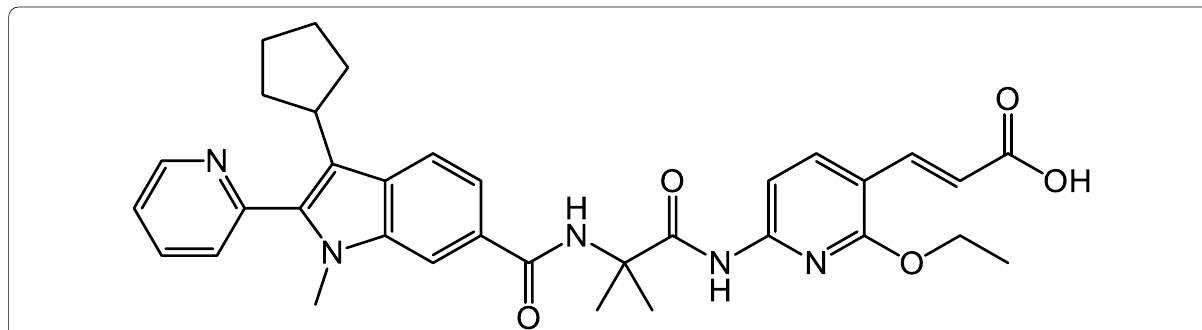
Fig. 4 (E)-3-[6-[[2-[(3-cyclopentyl-1-methyl-2-pyridin-2-ylindole-6-carbonyl)amino]-2-methylpropanoyl]amino]-2-ethoxypyridin-3-yl]prop-2-enoic acid (Template